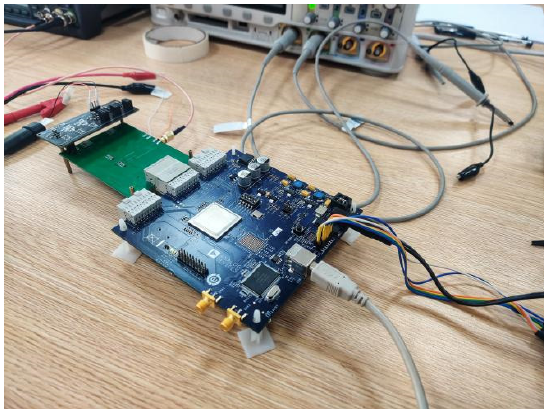
Figure 8. Field test diagram.